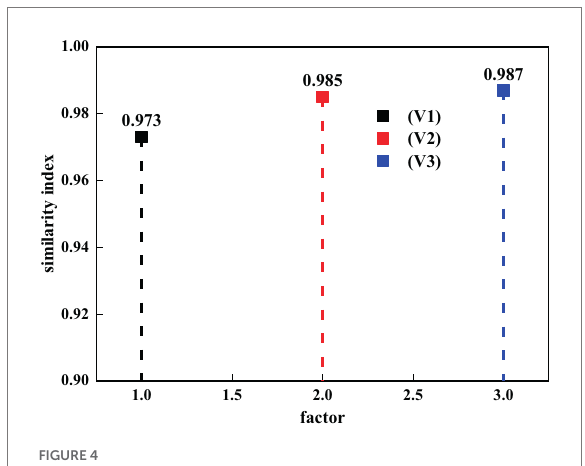
FIGURE 4 Similarity exponential distributions of mental health and literature transmission paths for CF algorithms.